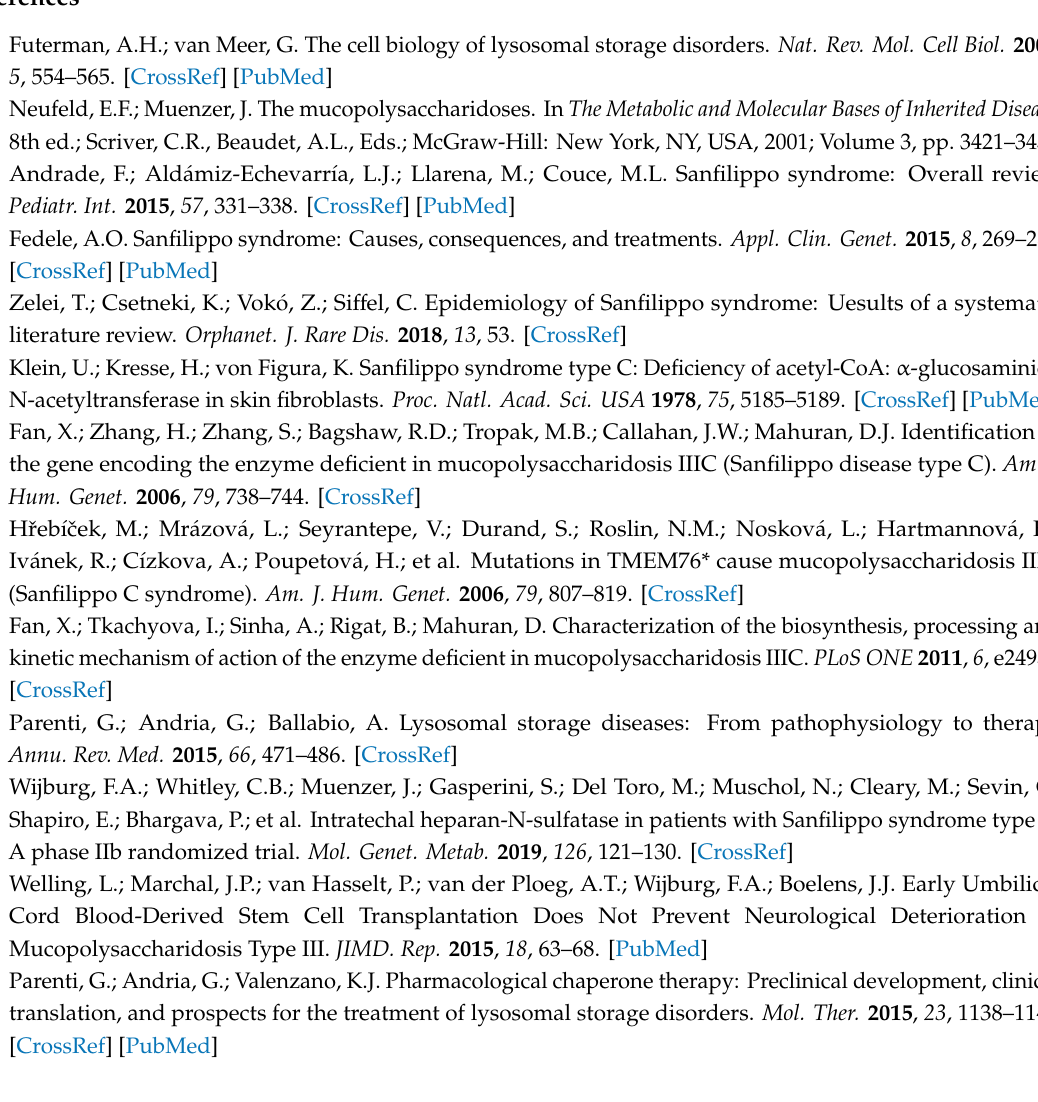
Table S1: Products used for human iPSCs maintenance; Table S2: Products used for lentiviral production; Table S3: Products used for the generation of induced neurons and astrocytes from iPSCs; Table S4: Products used for siRNA transfection, immunocytochemistry, RT-qPCR, ELISA, and protein quantification; Table S5: Antibodies used for immunocytochemistry; Table S6: TaqMan assays used for